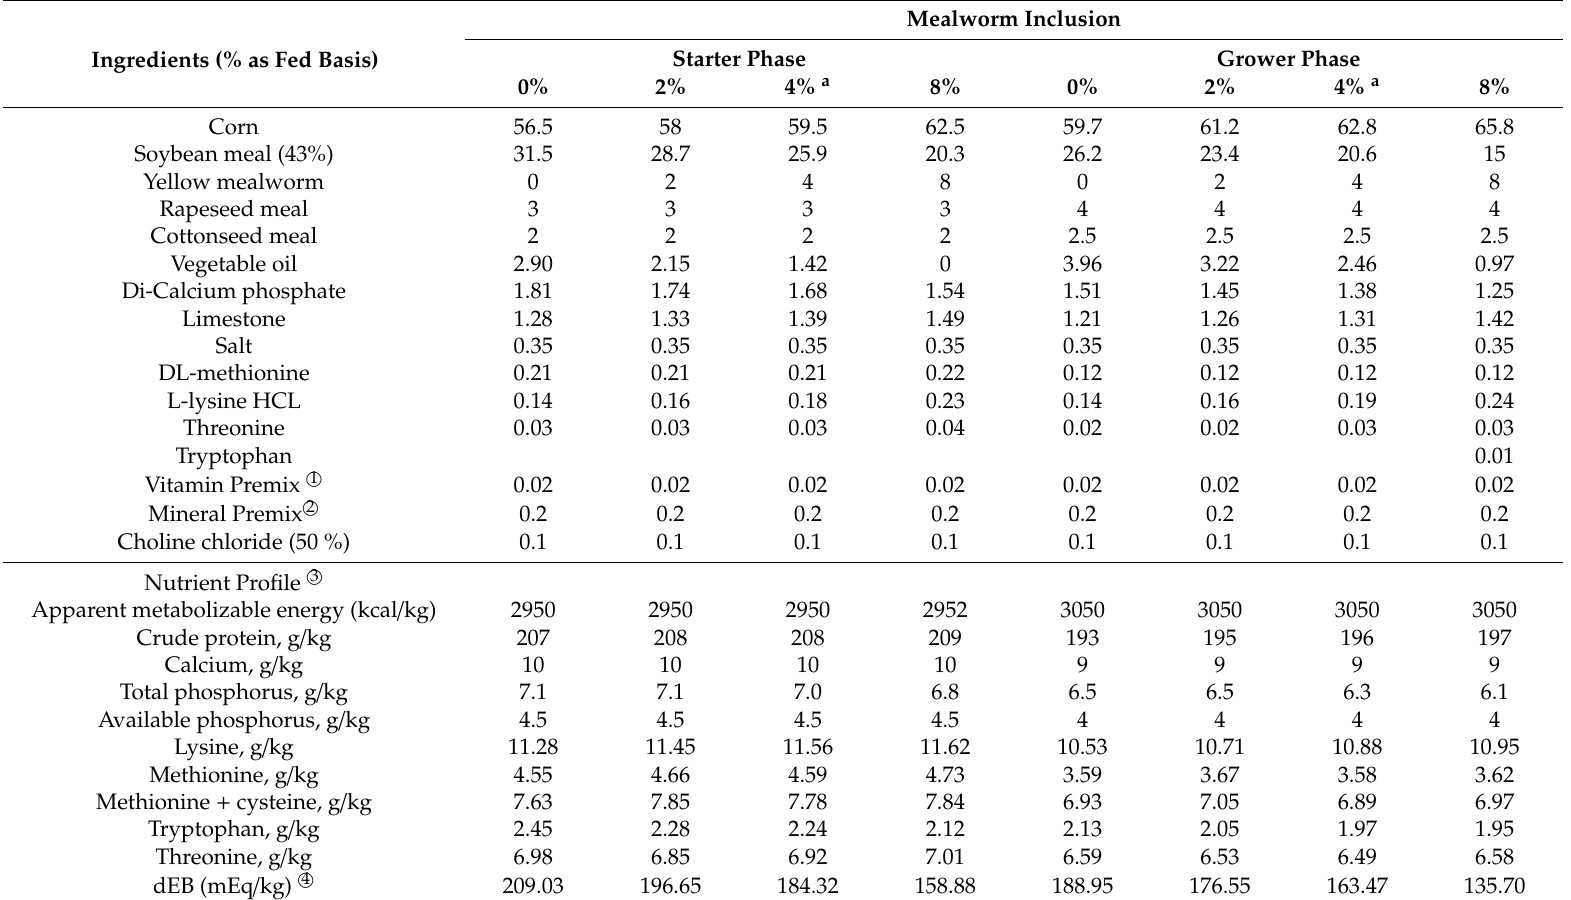
Table 1. Ingredients and nutritional level of the